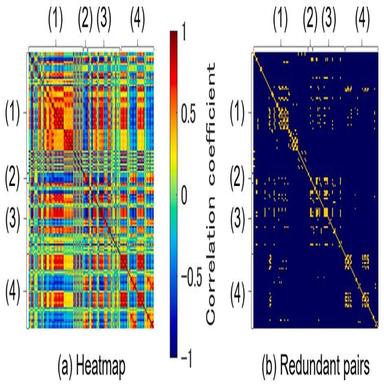
Correlation matrices (the four descriptor categories used for feature extraction are shown in both the matrices: (1) original structure, (2) medial axis, (3) pore-throat network, and (4) shortest path). (a) Heatmap of correlation matrix (each row and column represent a descriptor, and each element is colored according to the value of the correlation coefficient). (b) Redundant pairs indicated by yellow pixels.